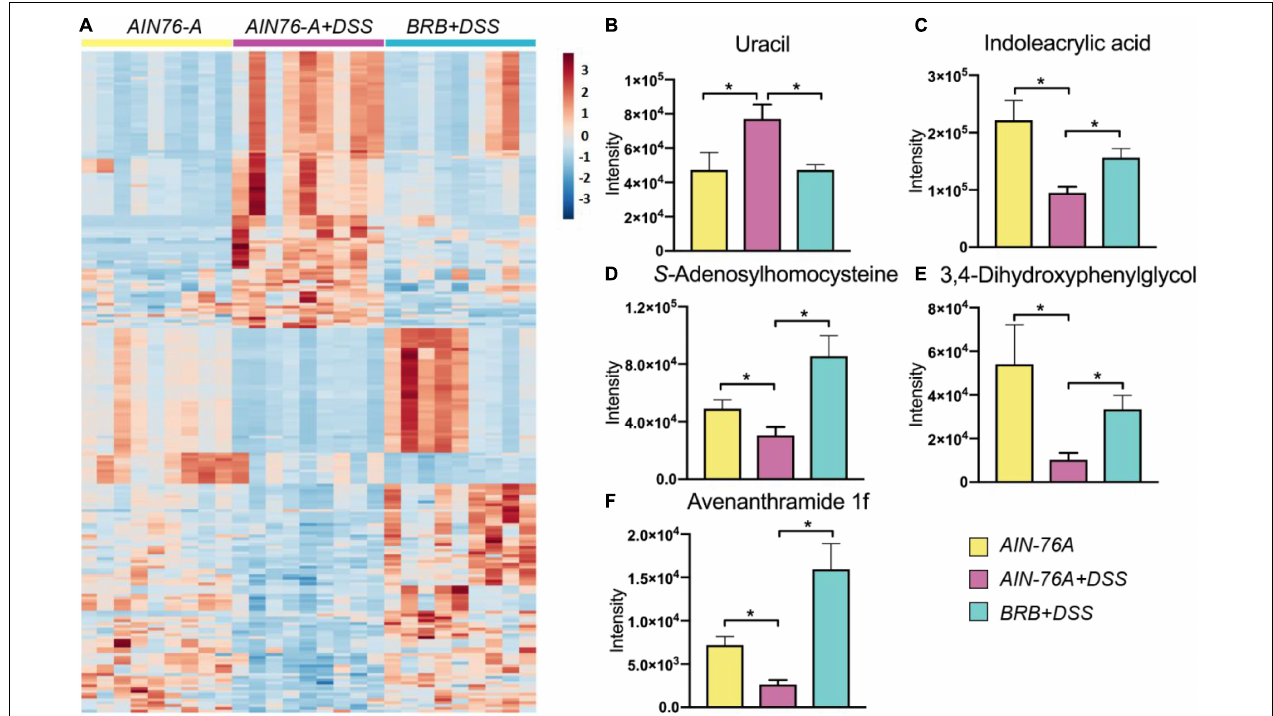
FIGURE 2 | Metabolic profiling of mouse plasma indicated that DSS treatment-induced host metabolic perturbation, at least in part, suppressed by BRB dietary intervention. (A) Heat map shows a clear restoration pattern of metabolic features by BRB dietary intervention. Plasma metabolites, including uracil (B) , indoleacrylic acid (C) , S-Adenosylhomocysteine (D) , 3,4-Dihydroxyphenylglycol (E) , and avenanthramide 1f (F) , are significantly changed by DSS treatment, and significantly suppressed by BRB dietary intervention. ( n = 9; data were expressed as mean with SEM, Welch’s two sample t -test was conducted AIN-76A vs. DSS, DSS vs. DSS + BRB, respectively; * p <